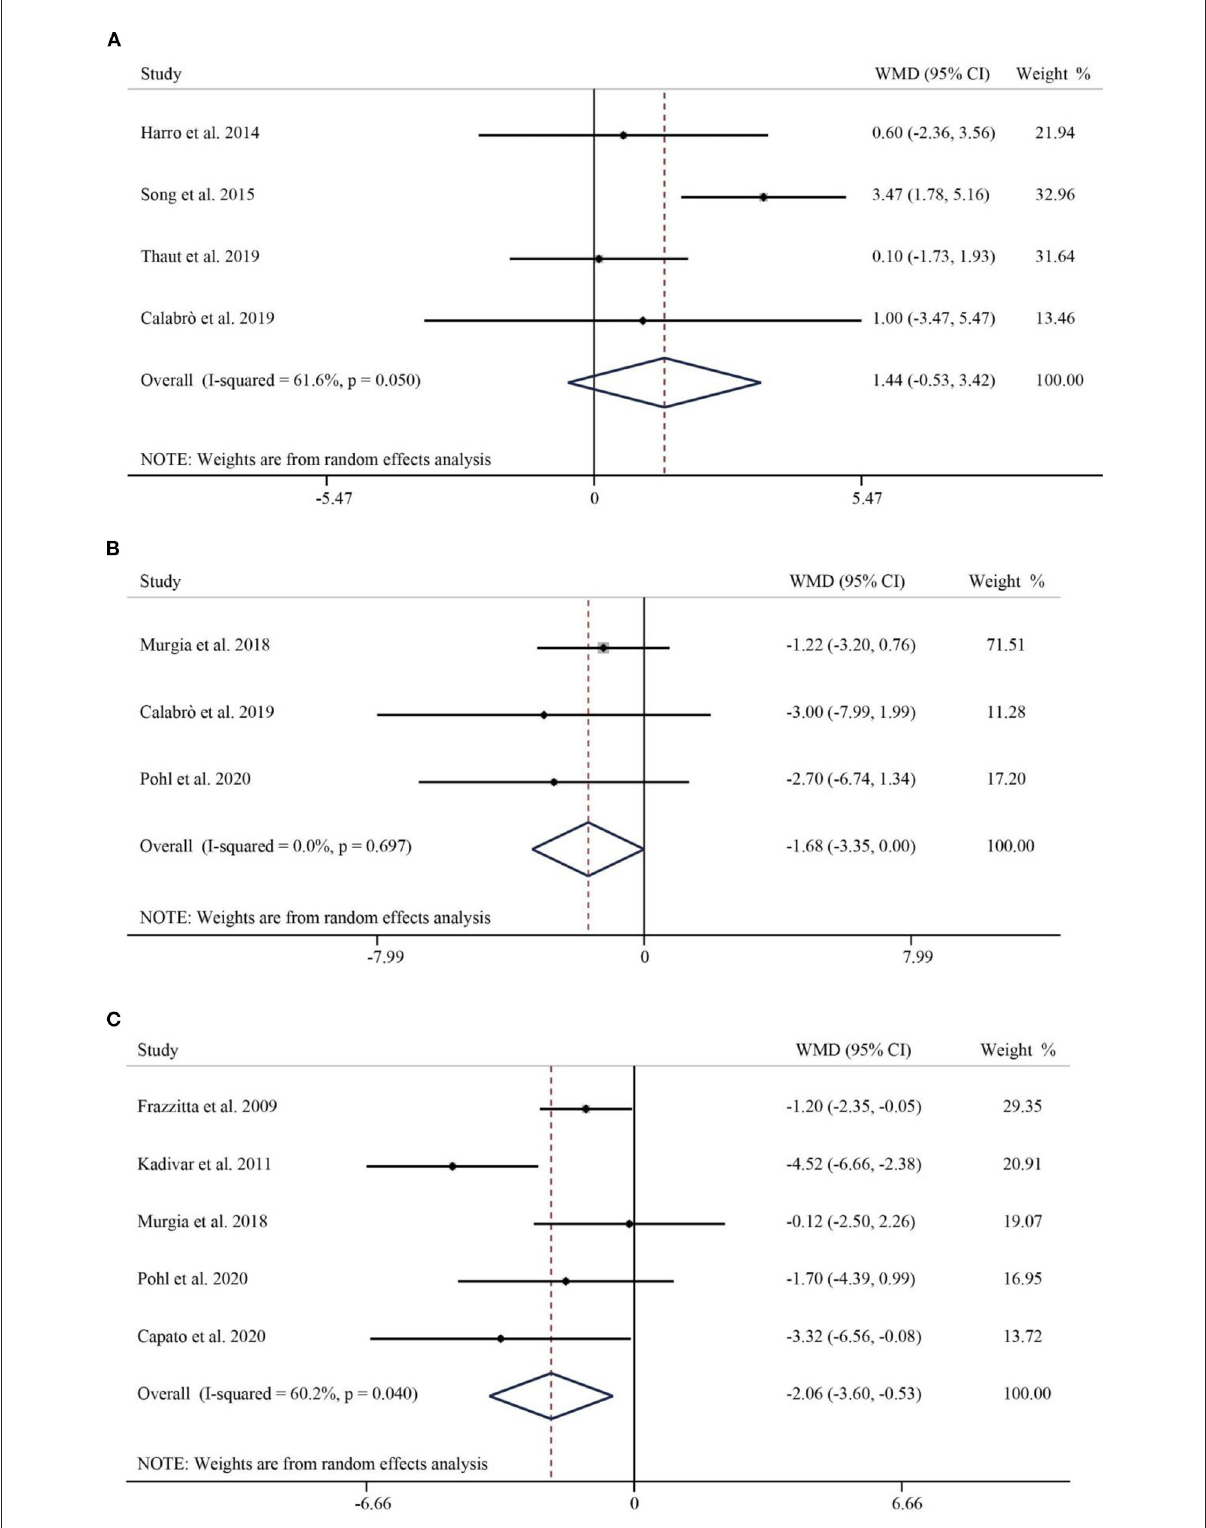
FIGURE4 Forest plot of RAS vs. the control group for BBS (A) , FES (B) , and FOGQ (C) . BBS, Berg Balance Scale; FES, Falls Efficacy Scale; FOGQ, Freezing of Gait